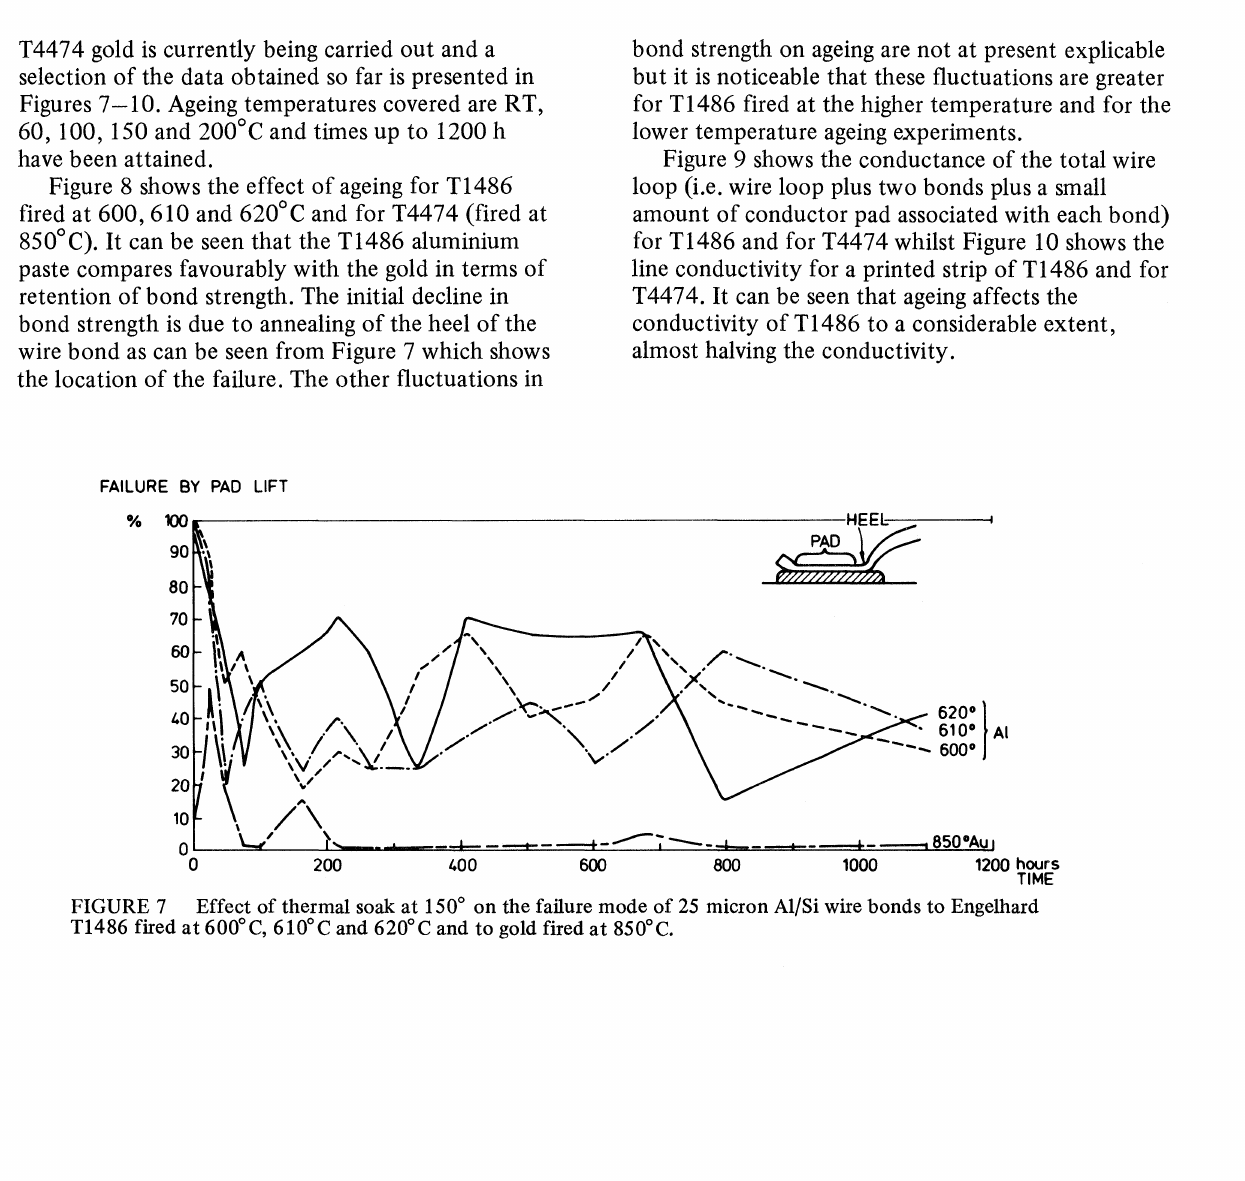
Bond strength for firing temperatures from 600C to 660C 25/m A1/1% Si wire bonded to T1486 aluminium paste.